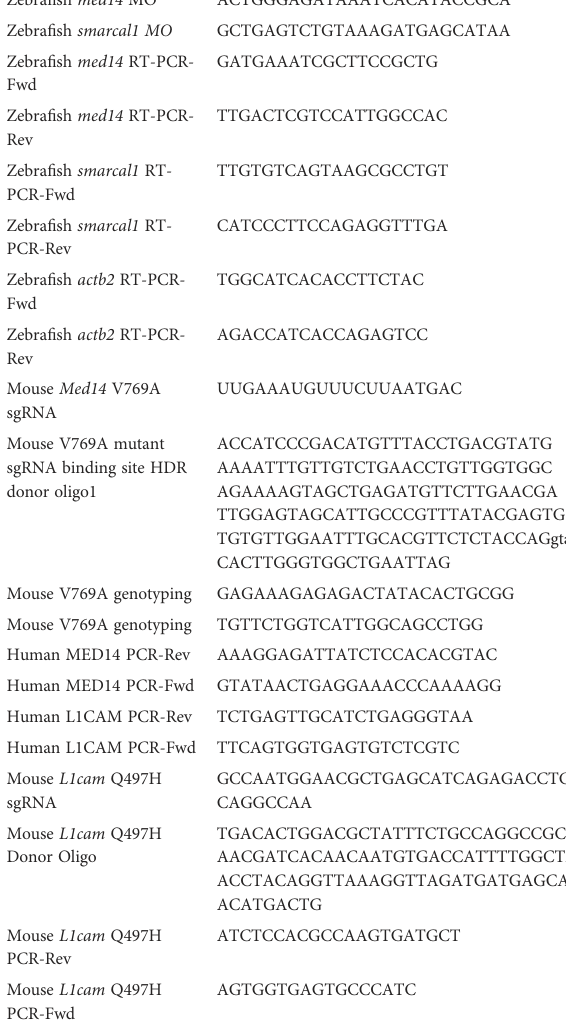
TABLE 1 Oligonucleotides used in this study. Zebra fi sh med14